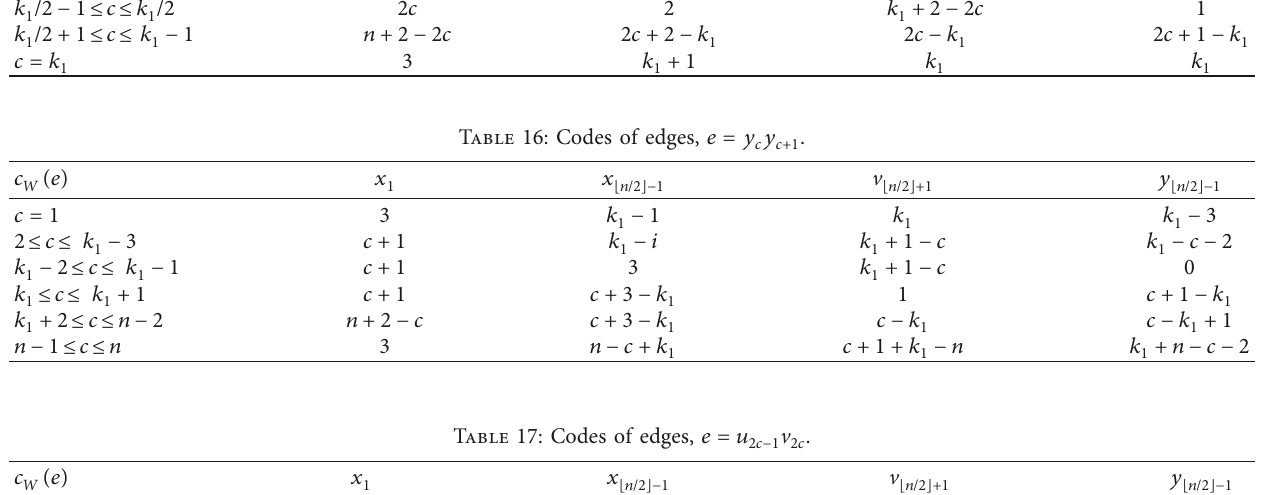
Table 15: Codes of edges, e � v